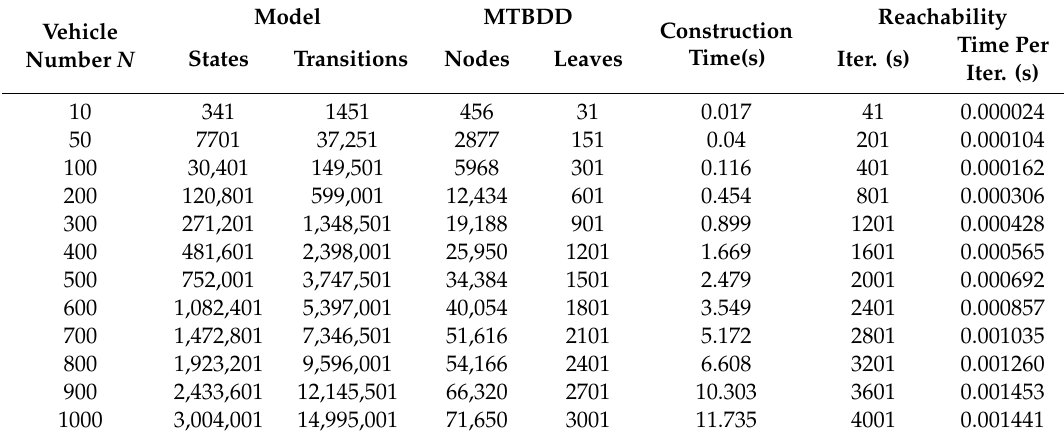
Table 2. Probability model test results of the survivability